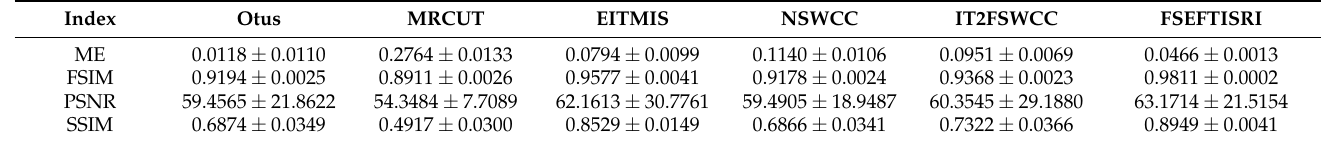
Table 3. Mean value and variance of evaluation indexes of 6 algorithms in NDT images.